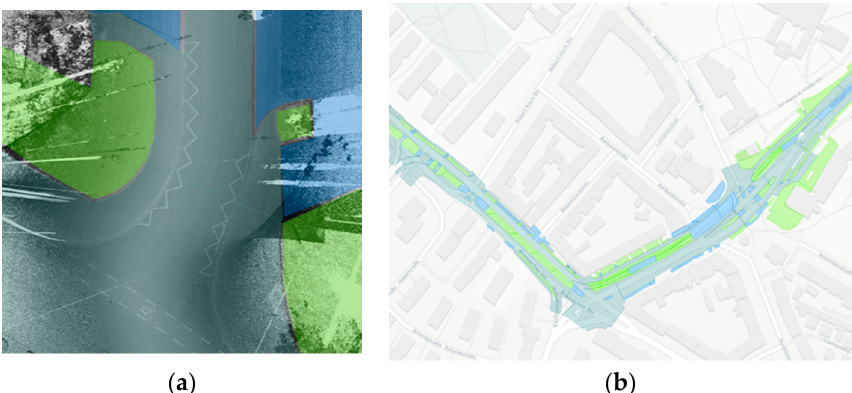
Figure 6. Details of reference map. Polygons for asphalt (grey), grass or dirt (green), and small pavement (light blue). ( a ) With overlay of point cloud from birds-eye view; ( b ) OSM at maximum zoom.